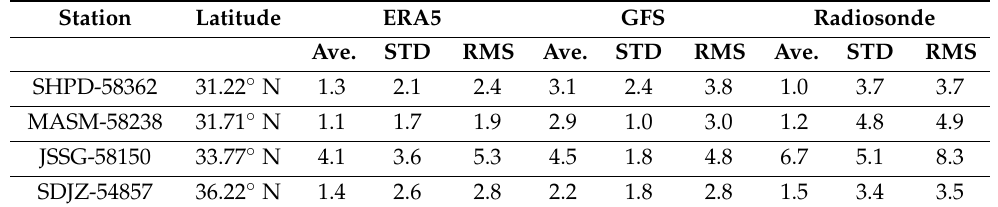
Figure 2. PWV comparisons of GPS (red dots), ERA5 reanalysis (blue dots), GFS analysis (brown triangles) and radiosonde (RS) (green circles) at four match stations: ( a ) SDJZ, ( b ) JSSG, ( c ) MASM and ( d ) SHPD. Table 1. Comparisons of PWV differences (in mm) for ERA5 reanalysis, GFS analysis and radiosonde with